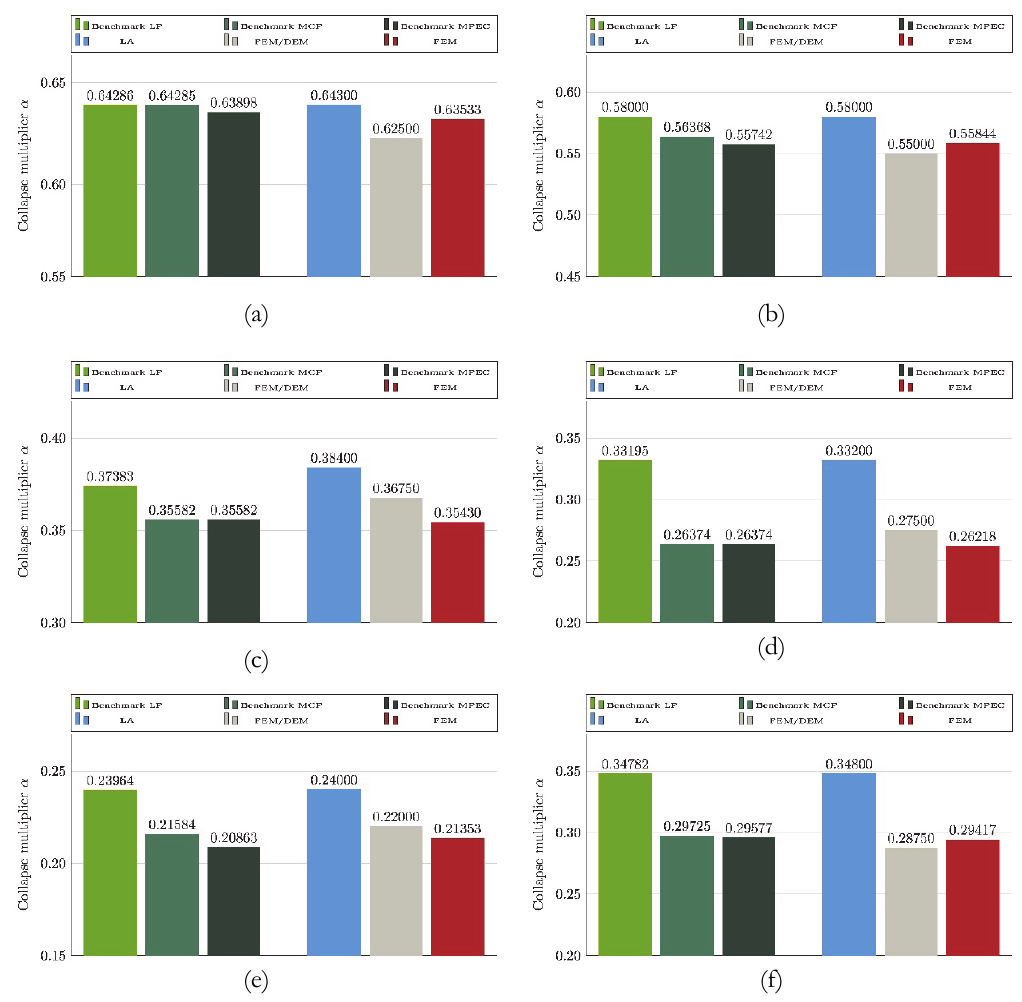
Figure 10: Comparison of the collapse multiplier for: ( a ) Example1, (b) Example2, (c) Example3, (d) Example4, (e) Example5, (f)